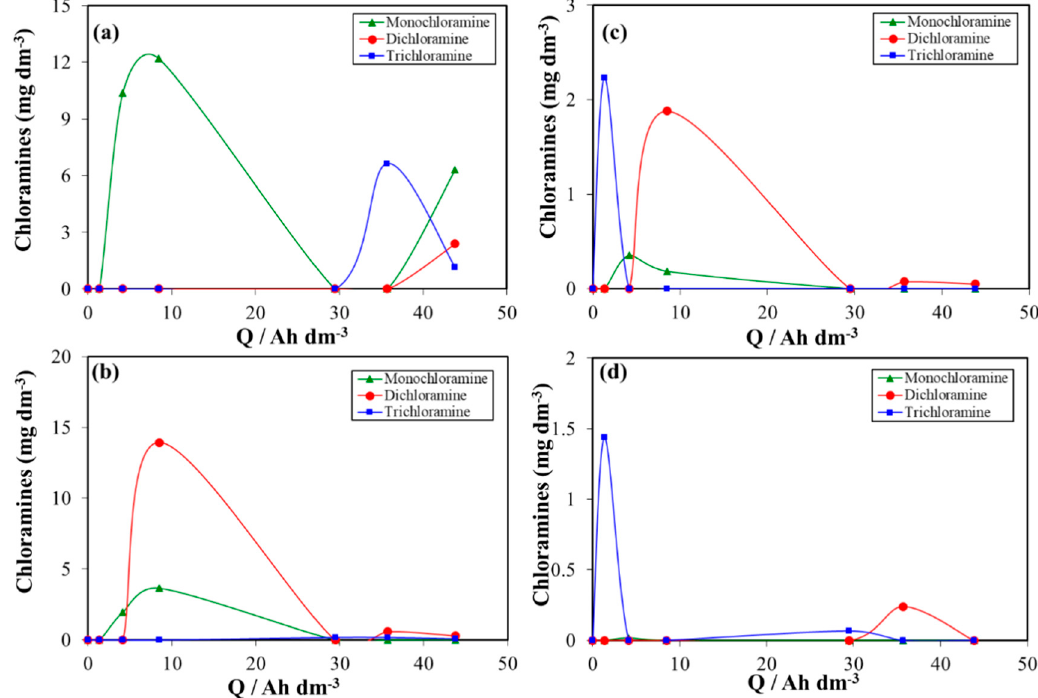
Figure 8. Changes in the concentration of chloramines ( (cid:78) monochloramine; (cid:8) dichloramine; (cid:4) trichloramine) with the applied electric charge during the electrochemical treatment of urine wastewaters with ( a ) RuO 2 , ( b ) IrO 2 , ( c ) Pt and ( d ) Boron doped diamond (BDD) anode materials.